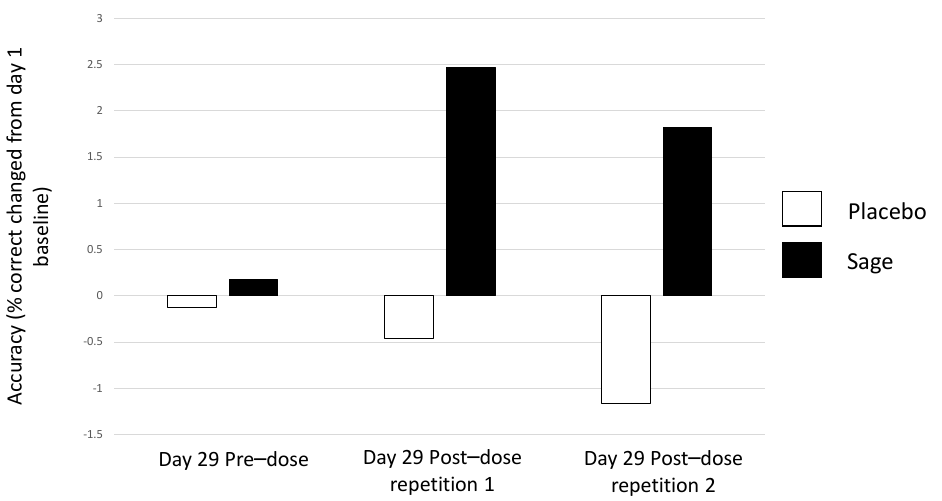
Figure 11. Pure chronic interaction between treatment × repetition on working memory accuracy on day 29: a significant pure chronic interaction between treatment × repetition ( p = 0.03) was observed on day 29, where accuracy was significantly better (as compared to baseline performance on day 1) in the sage condition at both post-dose repetition 1 and 2 as compared to the placebo condition.